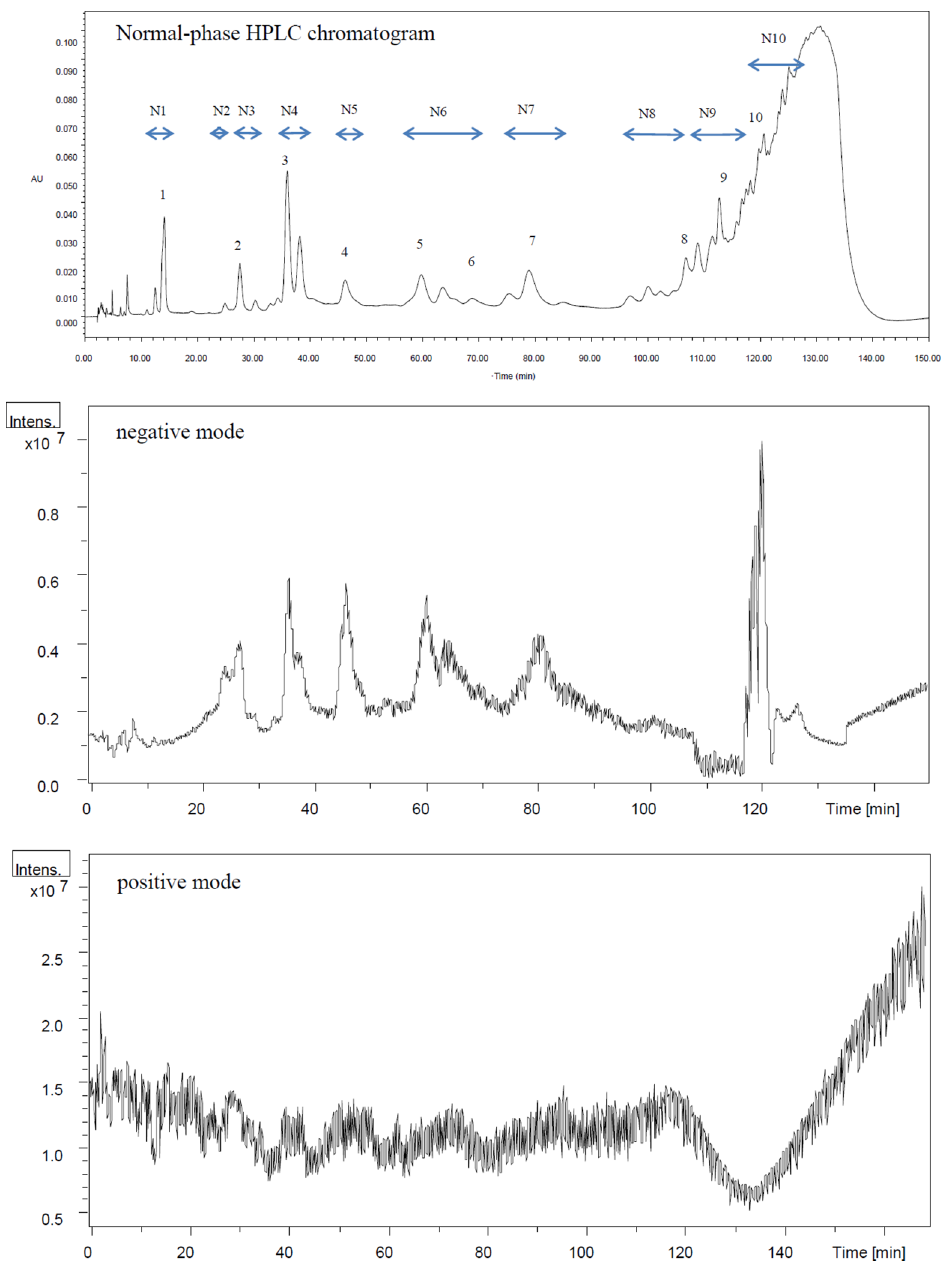
Figure 3. Normal-phase HPLC chromatograms and negative and positive ESI-MS spectra of Chinese bayberry leaf proanthocya- nidins. N1 to N10 referred to fractions collected from preparative normal-phase HPLC according to the collecting time in Table